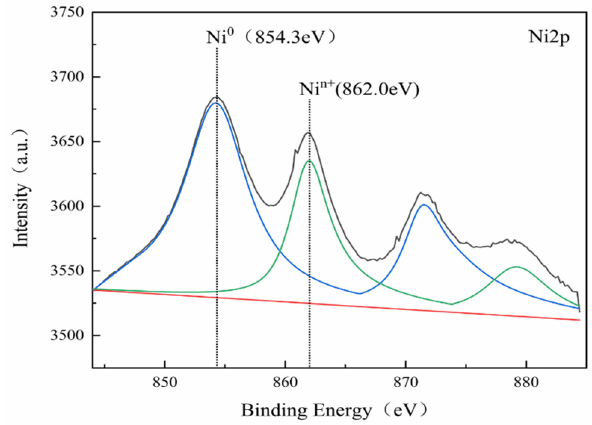
Figure 7. XPS spectra of the Ni 2p peaks of PN-1:1.